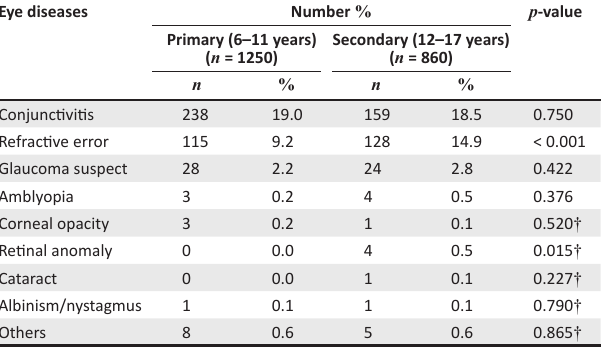
TABLE 4: Prevalence of eye diseases among primary (6–11 years) and secondary (12–17 years) school children. Eye diseases